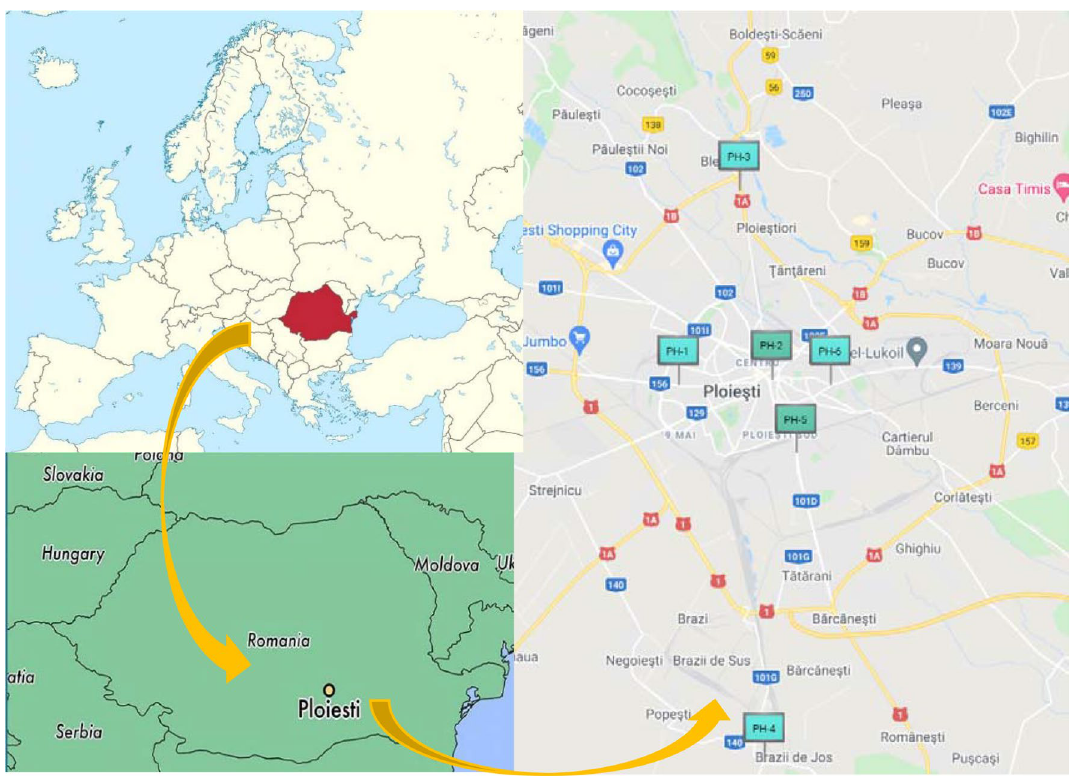
Figure 1. Geographical location of sampling site—Ploie ș ti city 26–28